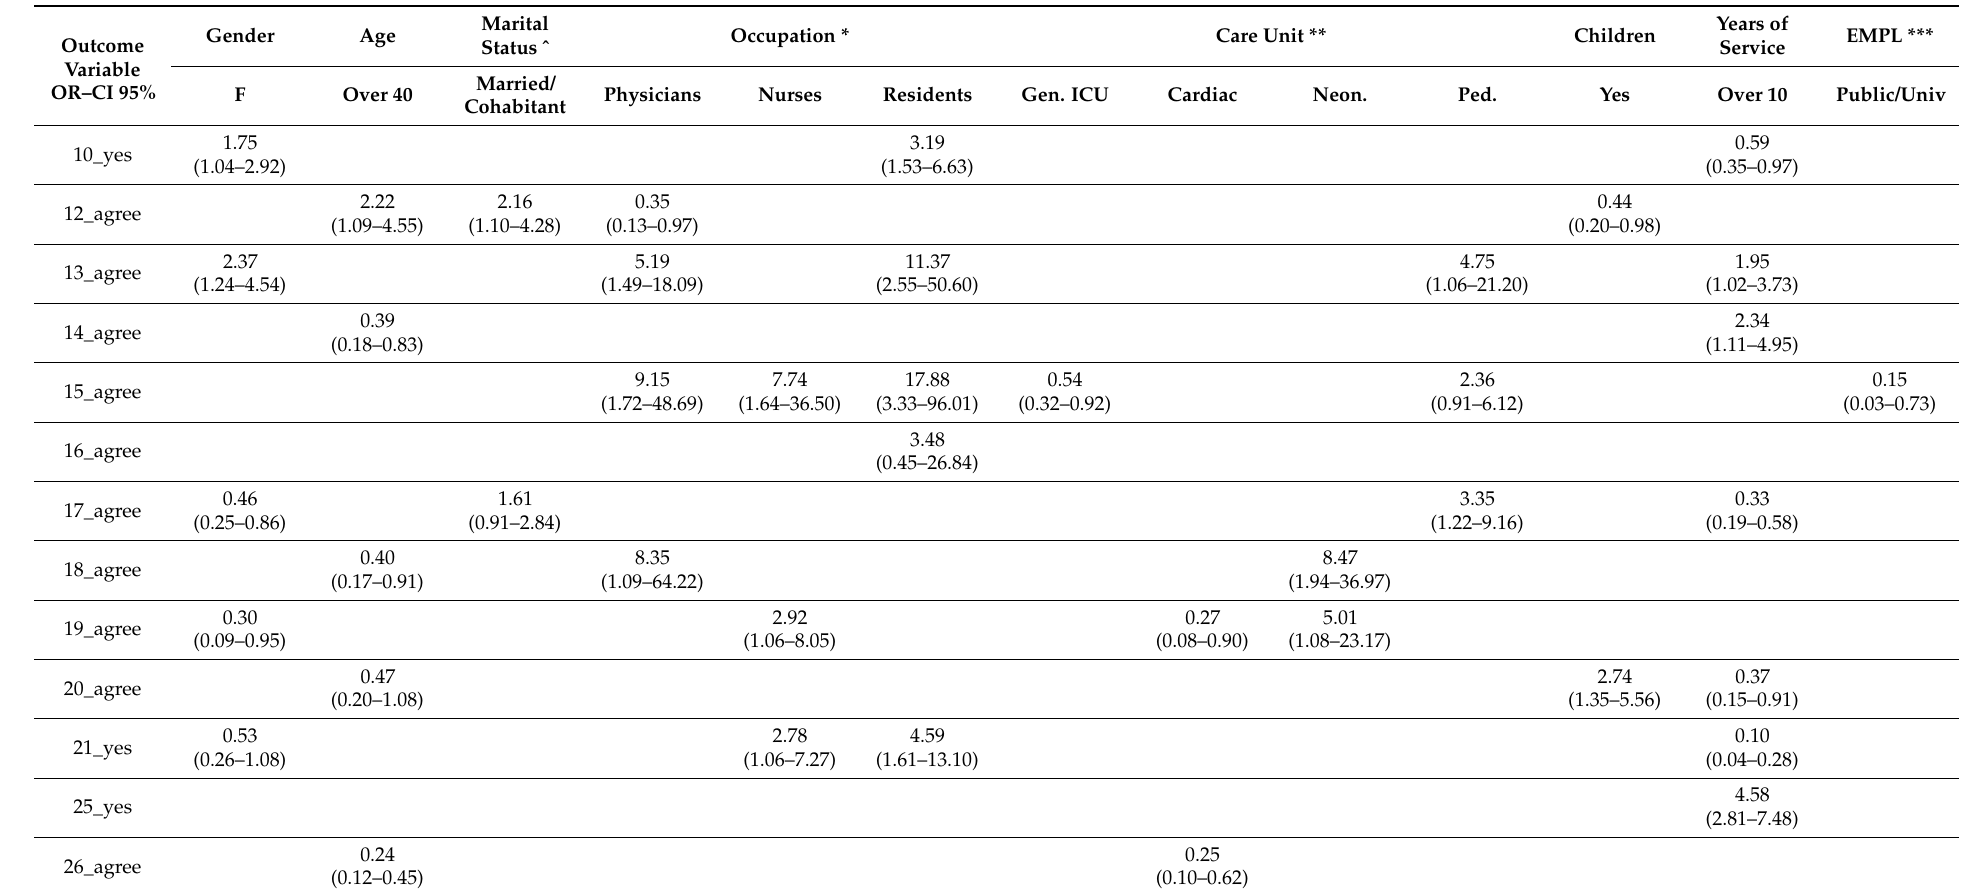
Table 3. Results of multivariate analysis—OR (95%CI) positive